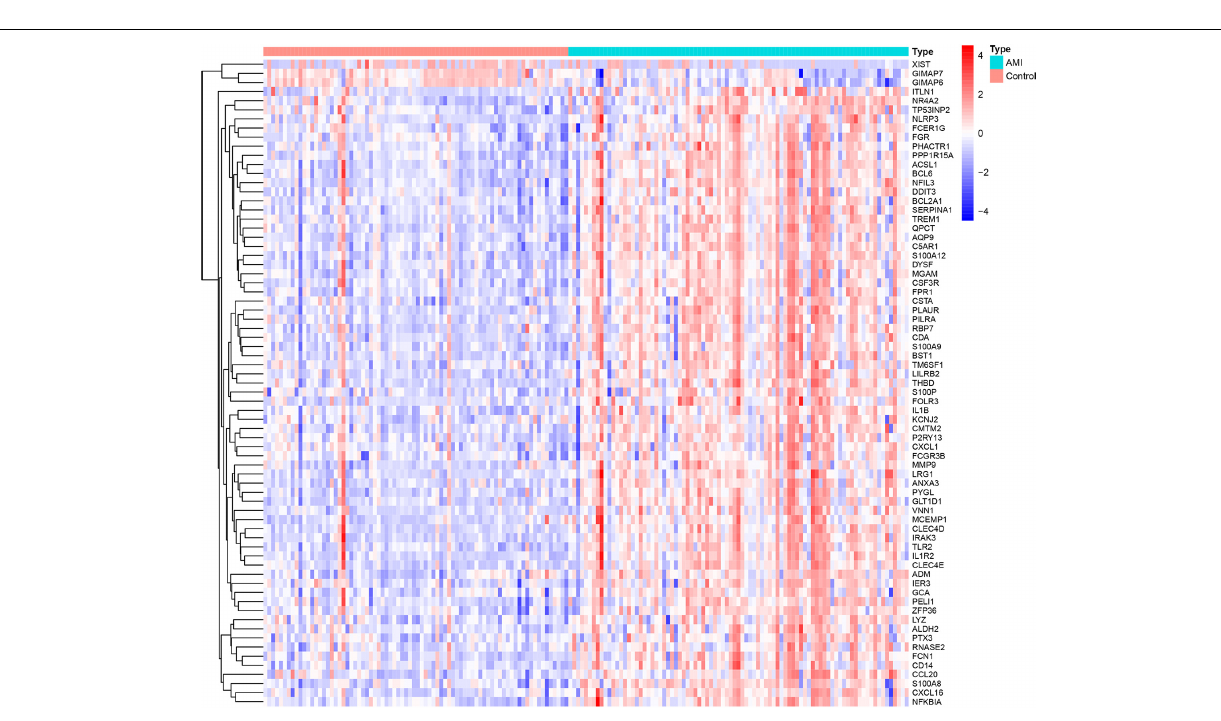
Frontiers in Cardiovascular Medicine |